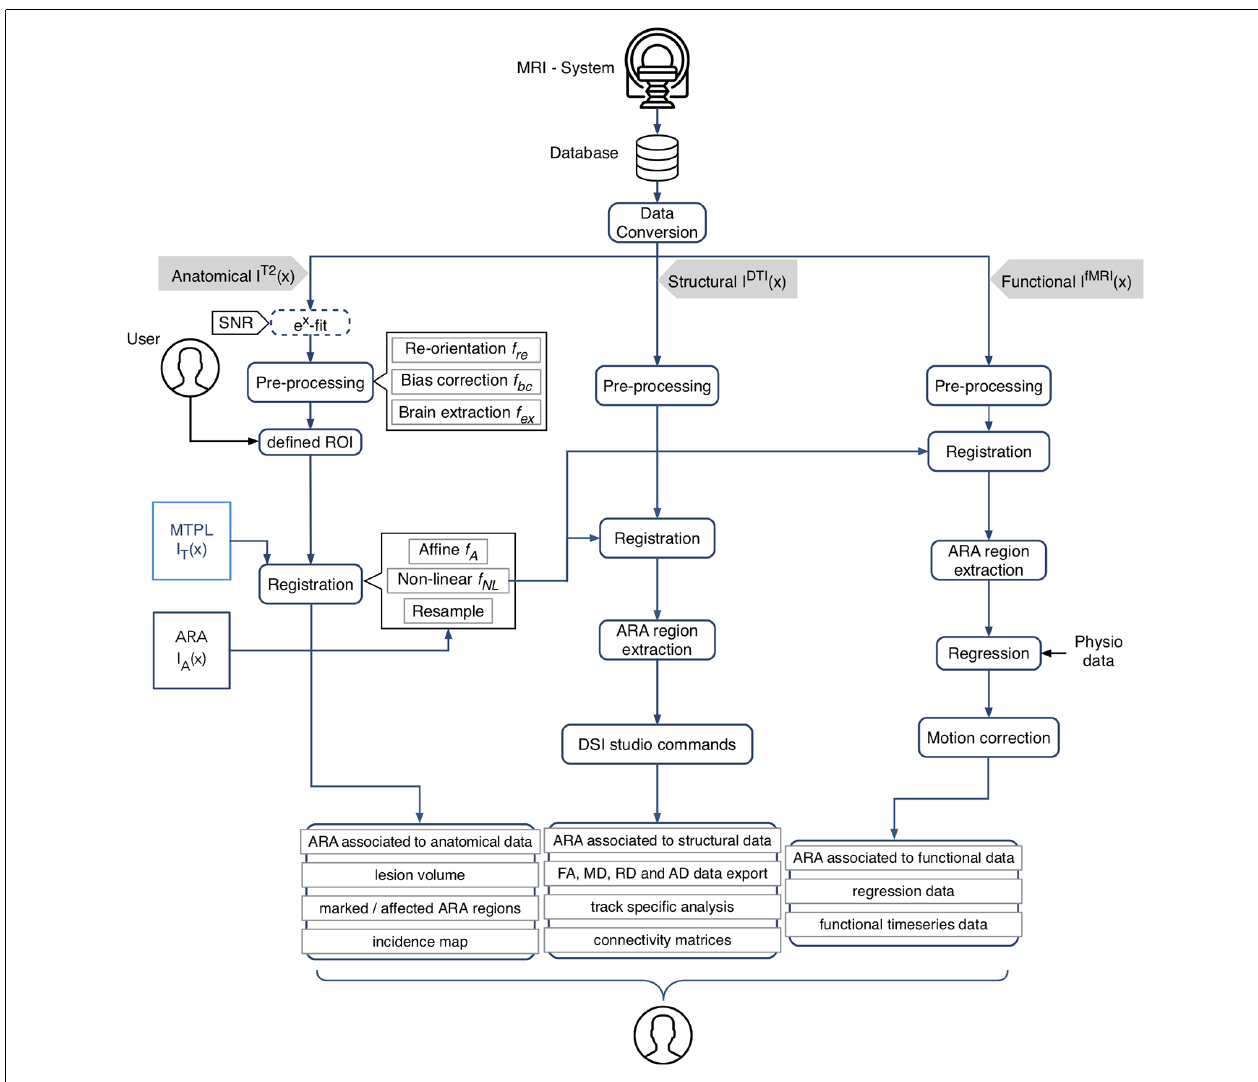
FIGURE 1 | Schematic overview of AIDAmri processing modules and subsequent computational steps for anatomical data (T2-weighted and T2 map), structural (diffusion tensor imaging, DTI) and functional data (resting-state functional magnetic resonance imaging, rs-fMRI). The given image function I ( x ) represents the 3D −→ −→ −→ MRI image space and describes all intensities at the position x = { x , y , z }. All data types are pre-processed using a re-orientation f re ( x ), bias correction f bc ( x ) and brain extraction f ex ( x ). The user has the opportunity to define individual regions of interest (ROIs), e.g., a lesion mask, to compare particular areas over different measurements by generating an incidence map. The combined transformation f of the affine f A and non-linear transformation f NL is applied to MRI template MTPL I T ( x ) and subsequently the ARA I A ( x ) with the pre-processed data set I T2 ( x ). DTI I DTI ( x ) and rs-fMRI I fMRI ( x ) processing steps were implemented based on established protocols (Budde and Song, 2010; Kim et al., 2012; Gorges et al., 2017). AIDAmri generates a variety of outputs such as the connectivity matrices which can be used for further atlas-based connectivity analysis. Icons designed by Smashicons from